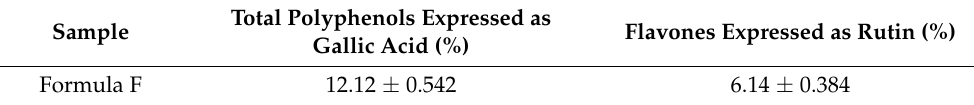
Table 1. Content of total polyphenols and flavones of formula F, determined spectrophotometrically.